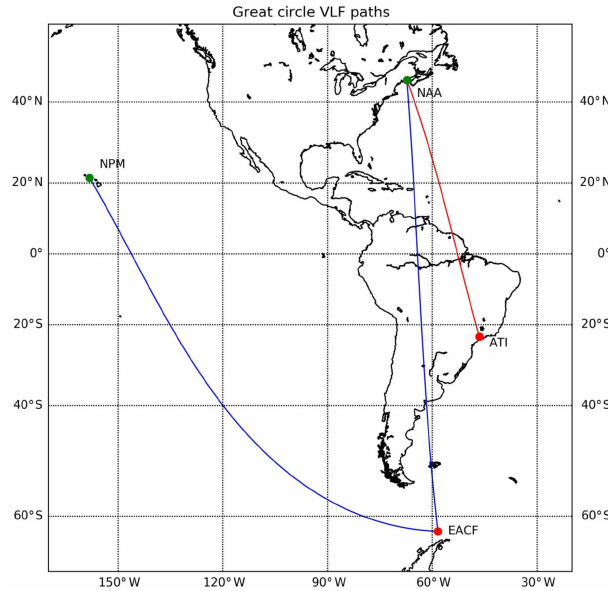
Figure 1. VLF propagation paths from NAA and NPM transmit- ters to the receiver stations located at Comandante Ferraz Brazilian Antarctic Station (EACF) (blue paths) and Atibaia, São Paulo (red